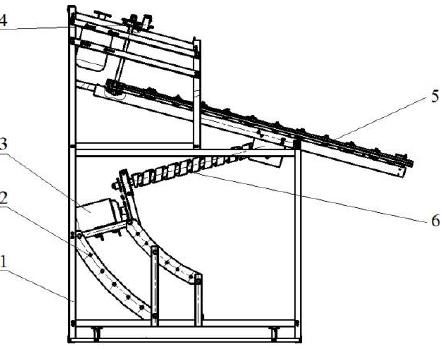
Figure 6. Structural diagram of a new bionic device for corn ear picking. 1. Frame. 2. Adjusting frame. 3. Adjustable speed motor. 4. Tension sprocket. 5. Clamping conveyor. 6. Snapping rolls.